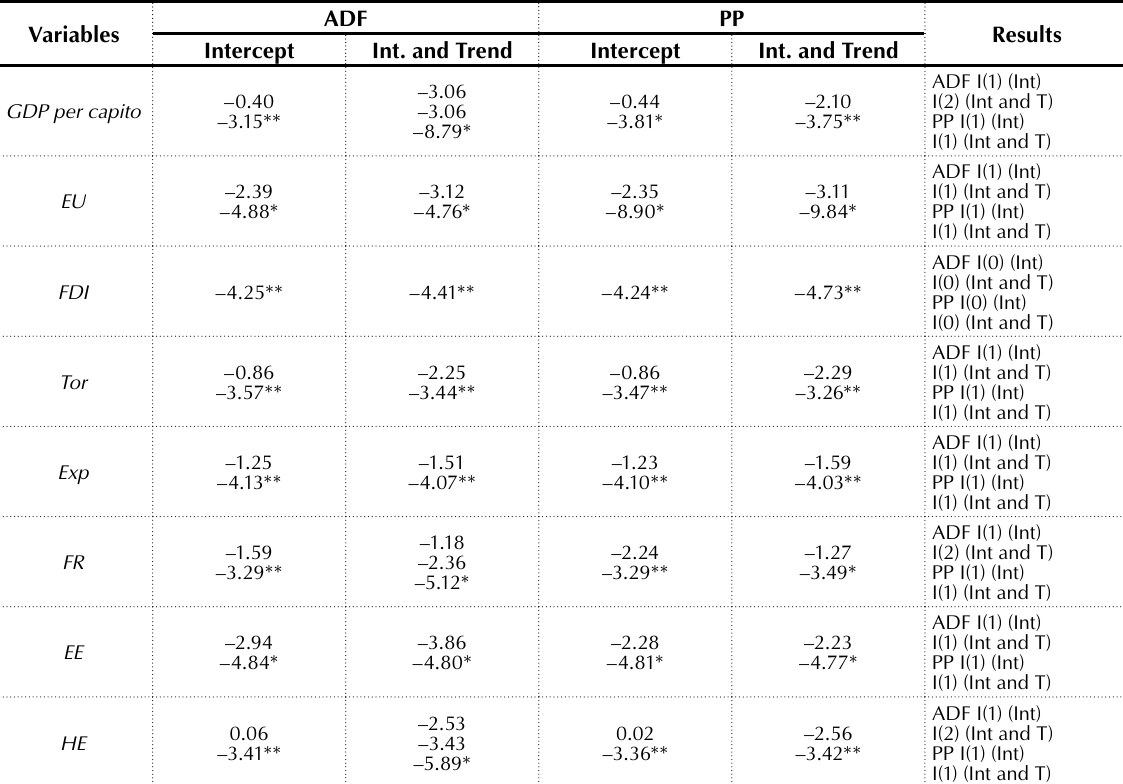
Table 1. ADF and Phillips and Perron (PP) unit root